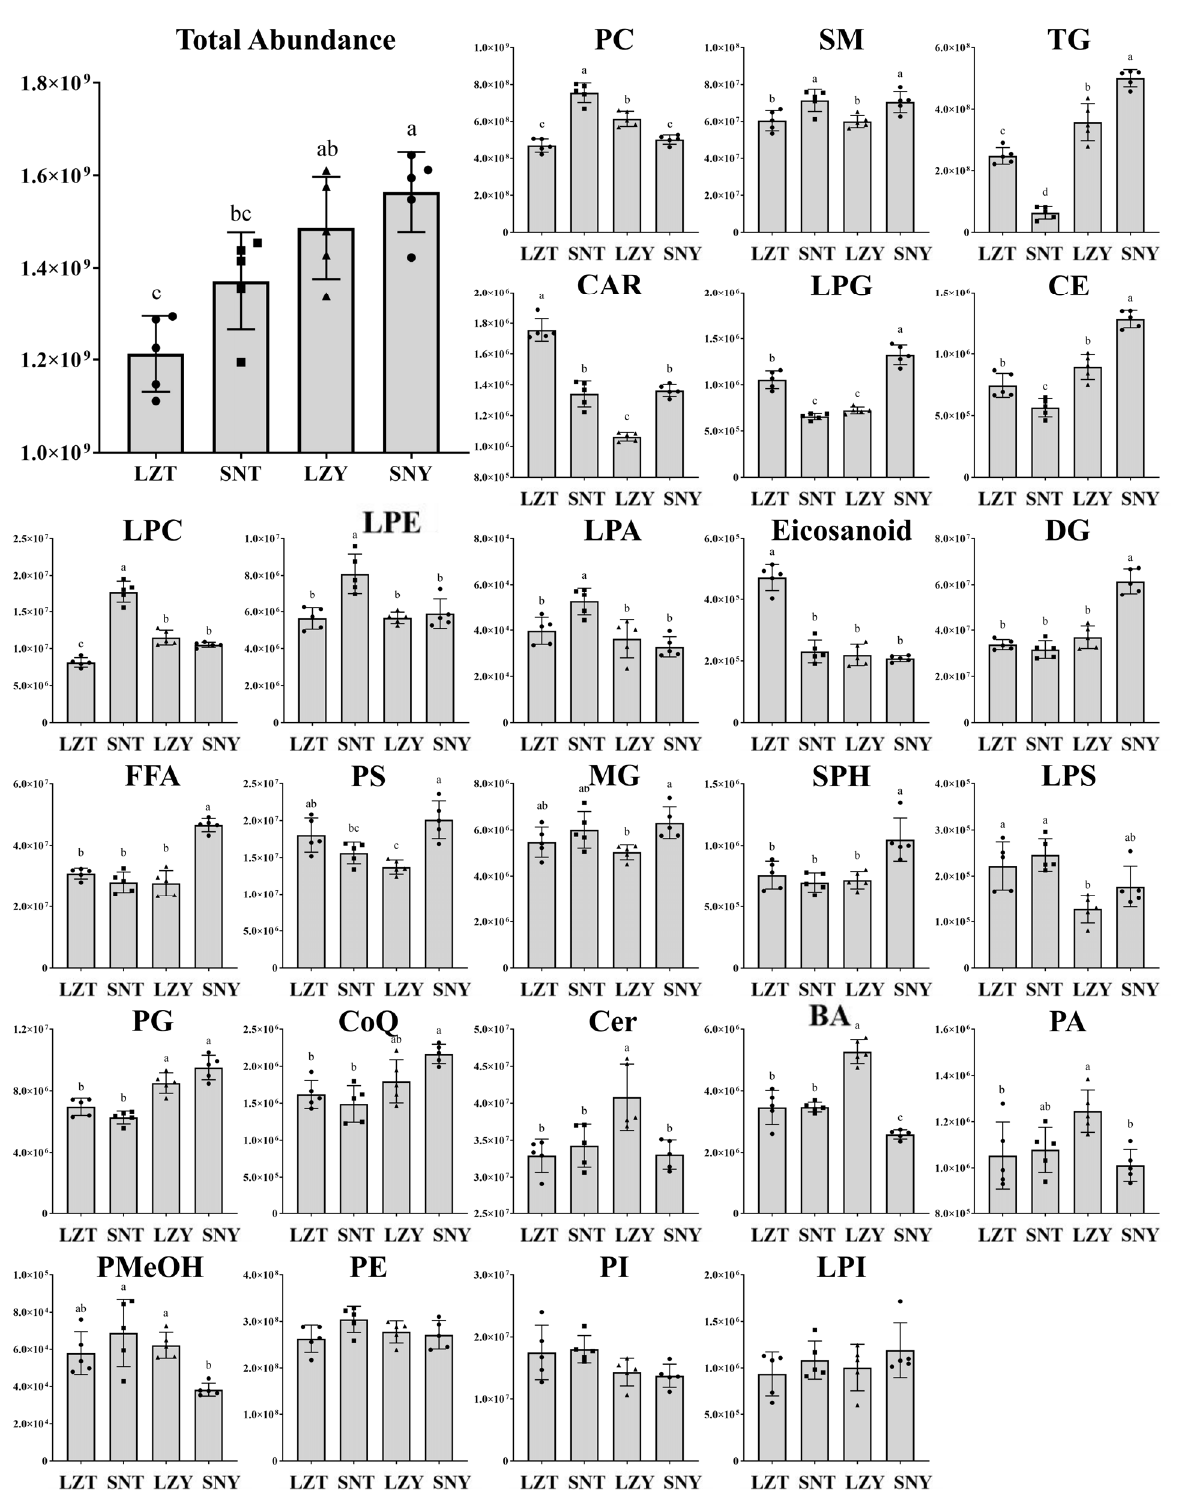
Figure 2. Comparison of the total lipid abundance and abundances of 25 lipid subclasses in the pig liver of different breeds raised at different altitudes. The ordinate is the ion intensity of lipid molecules in the mass spectrum (count per second). Significant differences ( p < 0.05) between the four groups are indicated by different lowercase letters (a–c).